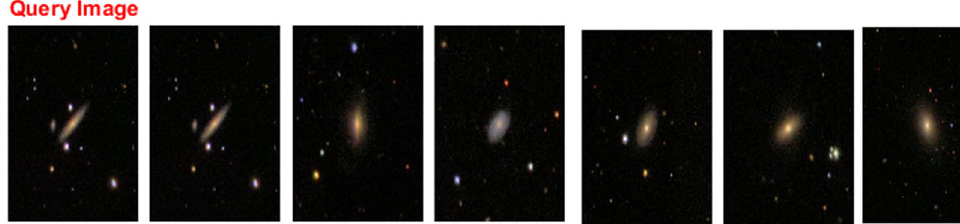
Figure 3. Galaxy image retrieval for an edge-on spiral galaxy 29